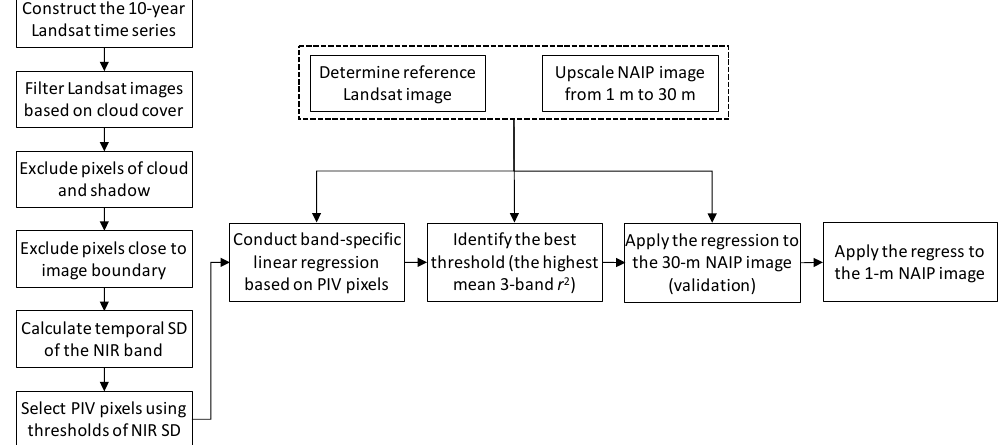
Figure 3. The flowchart of the proposed pseudoinvariant near-infrared threshold (PINT) method.